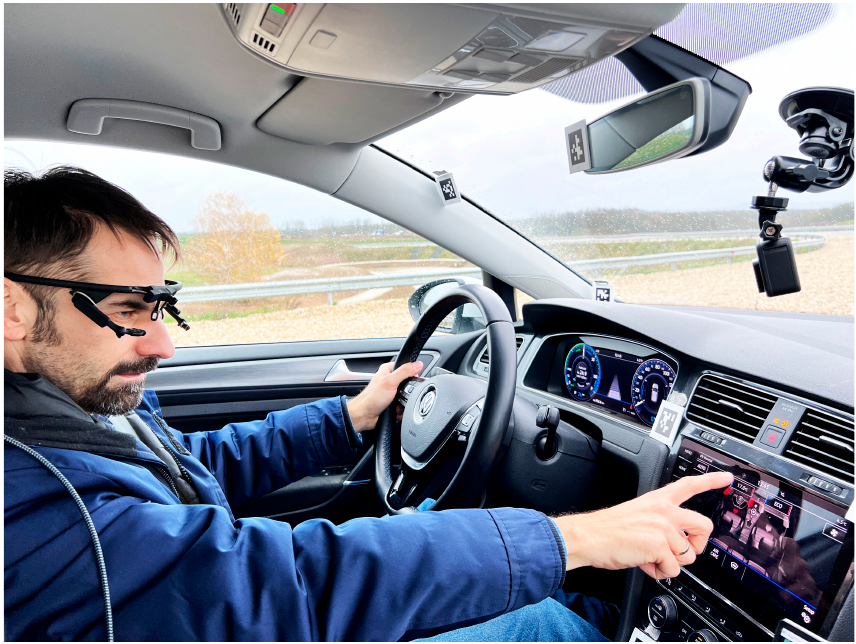
Figure 2. Test apparatus: Pupil Core eye-tracking device installed on the head of driver; HD camera in front of the driver; ID tags in the view of driver (around windshield and center console).